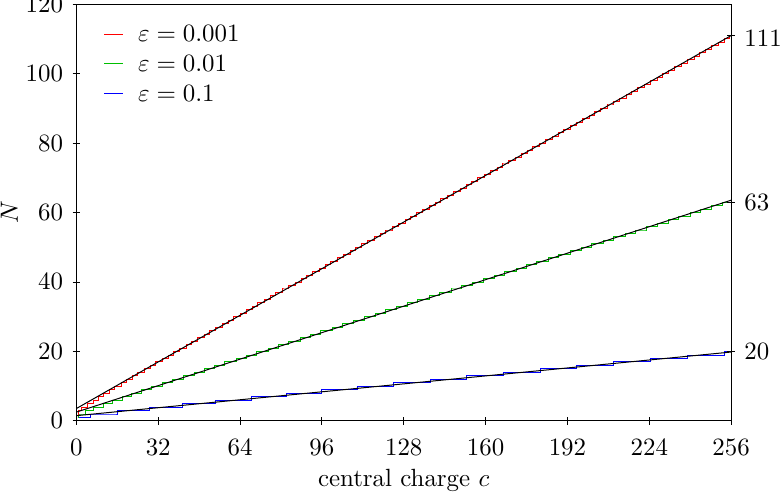
Figure 18 . Minimal N such that ∆ LP ,N with the least squares regression